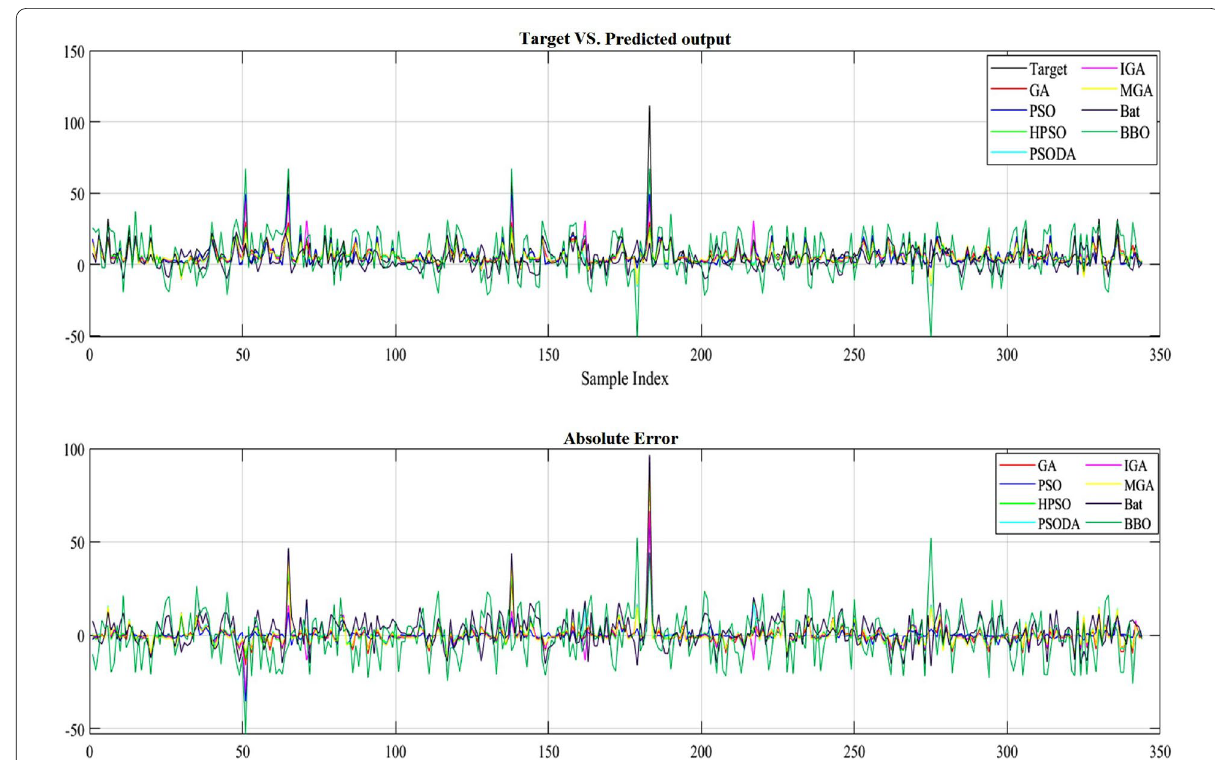
Fig. 11 Performance and absolute error of various approaches through training